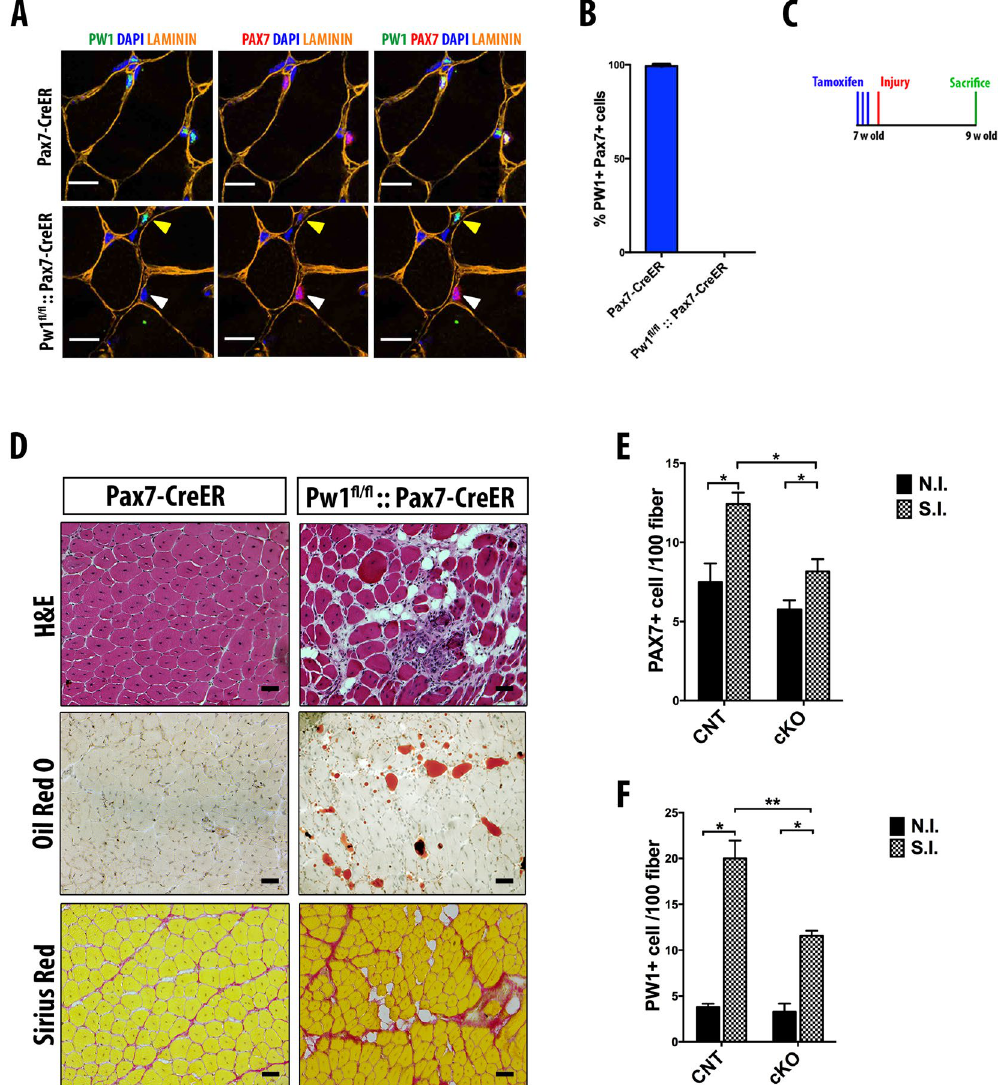
Figure 4. Specific Pw1 deletion in PAX7 positive cells leads to impairment in satellite cell self-renewal. (A) Representative cross-section of 4 weeks-old Pax7 -Cre and Pax7 -Cre:: Pw1 fl/fl TA one week after TM injection stained for PAX7 (red), PW1 (green), LAMININ (orange) and DAPI (blue). White and yellow arrows in Pax7 -Cre:: Pw1 fl/fl TA one week after TM injection indicate Pw1 deletion in satellite and interstitial PW1 + cells (PICs) respectively. Scale bar = 10 µ m. (B) Percentage of PW1 + PAX7 + cells in 4 weeks-old Pax7 -Cre and Pax7 -Cre:: Pw1 fl/fl TA one week after TM injection stained as shown in (A) (n = 3 for each assay and genotype). All PAX7 + cell from Pax7 -Cre:: Pw1 fl/fl TA do not express PW1 as compared to Pax7 -Cre TA . ( C ) Schematic representation of experimental strategy: seven weeks old Pax7 -Cre and Pax7 -Cre:: Pw1 fl/fl mice were injected intraperitoneally with TM for three days. One day after the last TM injection, TA muscles were injured by a single CTX injection. Muscles were collected two weeks after injury. ( D ) Cross-sections images of TA muscles from Pax7 -Cre and Pax7 -Cre:: Pw1 fl/fl mice two weeks after CTX injury stained with hematoxylin and eosin (upper panels ) , Sirius Red (middle panels) and Oil-Red O (lower panels). Specific deletion of PW1 in satellite cells impairs skeletal muscle regeneration. ( E , F ) Quantification of satellite cells (PAX7 + ) and PICs (PW1 + ) per 100 fibers in TA from Pax7 -Cre and Pax7 -Cre:: Pw1 fl/fl mice two weeks after CTX injury (n = 3 for each assay and genotype). Regenerating myofiber in Pw1 depleted satellite cells have less number of satellite cells and PICs. Values represent the mean number of positive cells ± s.e.m. per 100 fibers. Statistical analyses were performed using Student’s t-test * P < 0.05, ** P < 0.01 and *** P <